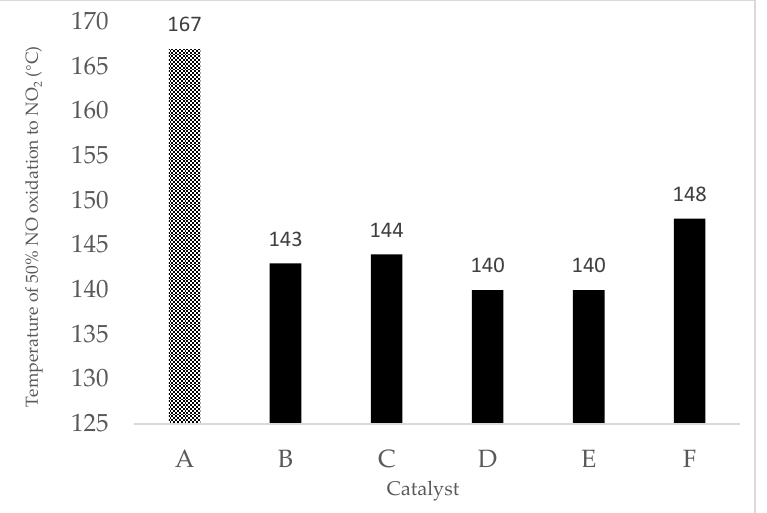
Figure 10. Reaction temperature for oxidation of 50% NO to NO 2 : (A) 9MnO 2 –1CeO 2 , (B) Co/9MnO 2 –1CeO 2 , (C) Ni/9MnO 2 –1CeO 2 , (D) Fe/9Mn–1CeO 2 , (E) Cu/9MnO 2 –1CeO 2 , and (F) Cr/9MnO 2 –1CeO 2 .